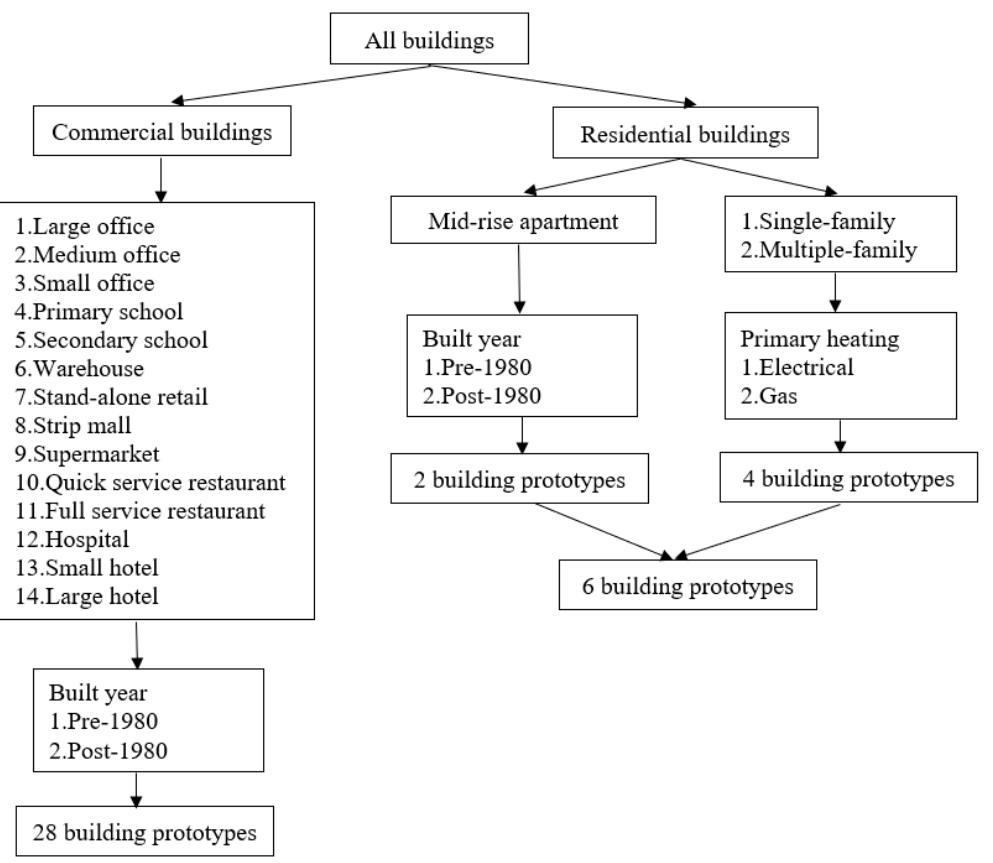
Figure 3. Building typology of the proposed study.